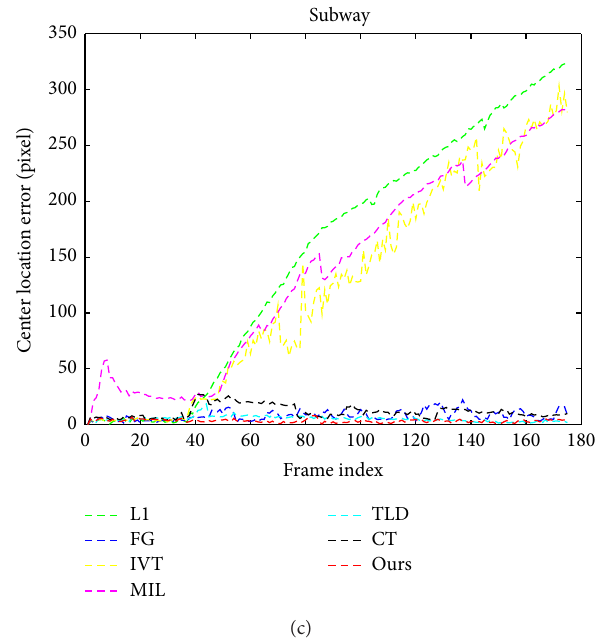
Figure 8: Quantitative evaluation of the trackers in terms of position errors (in pixels).